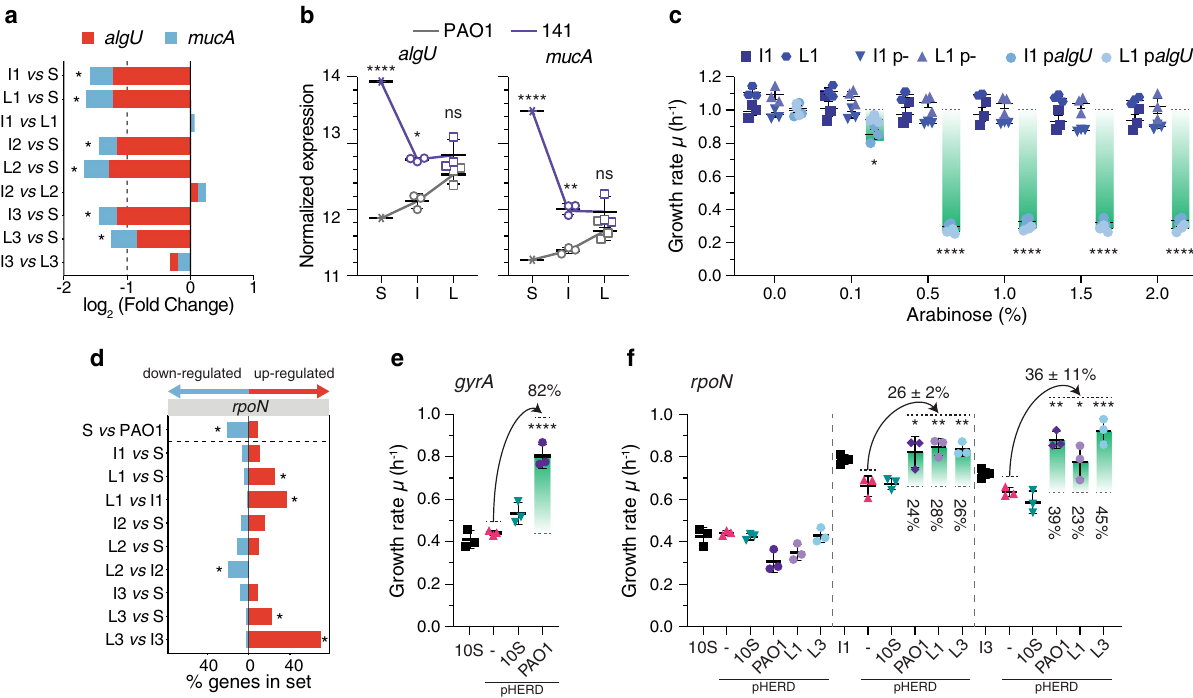
Fig. 3 Mutations and transcriptional pro fi le changes leading to increased growth rate in the evolved strains. a Expression of algU and mucA genes in 141 strains. The asterisks indicate statistically signi fi cant differences in the level of expression for both genes among the compared pairs of strains calculated by negative binomial distribution testing (adjusted P value < 0.01). b Normalized expression level of algU and mucA genes in S, I and L strains of PAO1 and 141. Statistical signi fi cance was calculated by two-way ANOVA with Sidak ’ s multiple comparison test ( P values: *<0.05; ****<0.0001; ns not signi fi cant; n = 3 biologically independent strains). Data are presented as mean values ± SD. c Growth rate reduction in strains 141_I1 and 141_L1